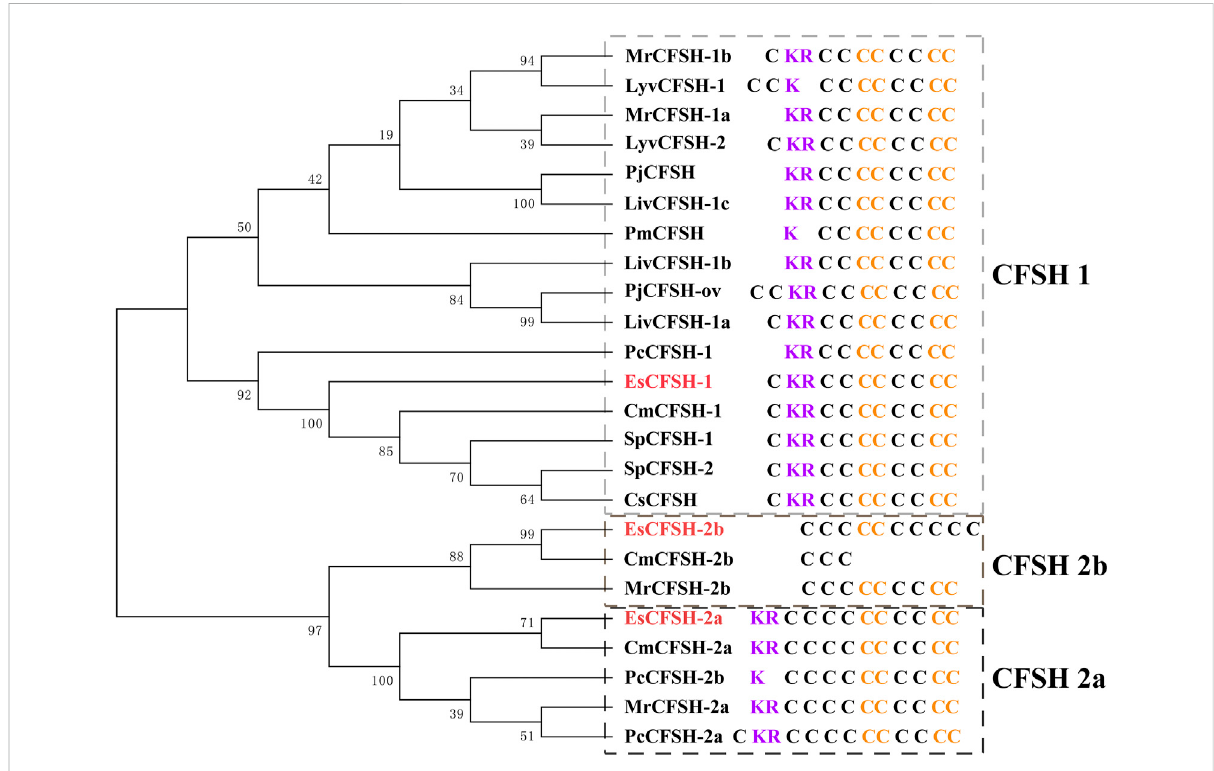
FIGURE 4 The phylogenetic analysis of the CFSH mature peptides from decapod crustaceans. Three EsCFSHs from E. sinensis (marked in red) and homologous proteins from other decapod species (Table 2). The details of conserved cysteine residues and KR site were shown on the right side following the gene